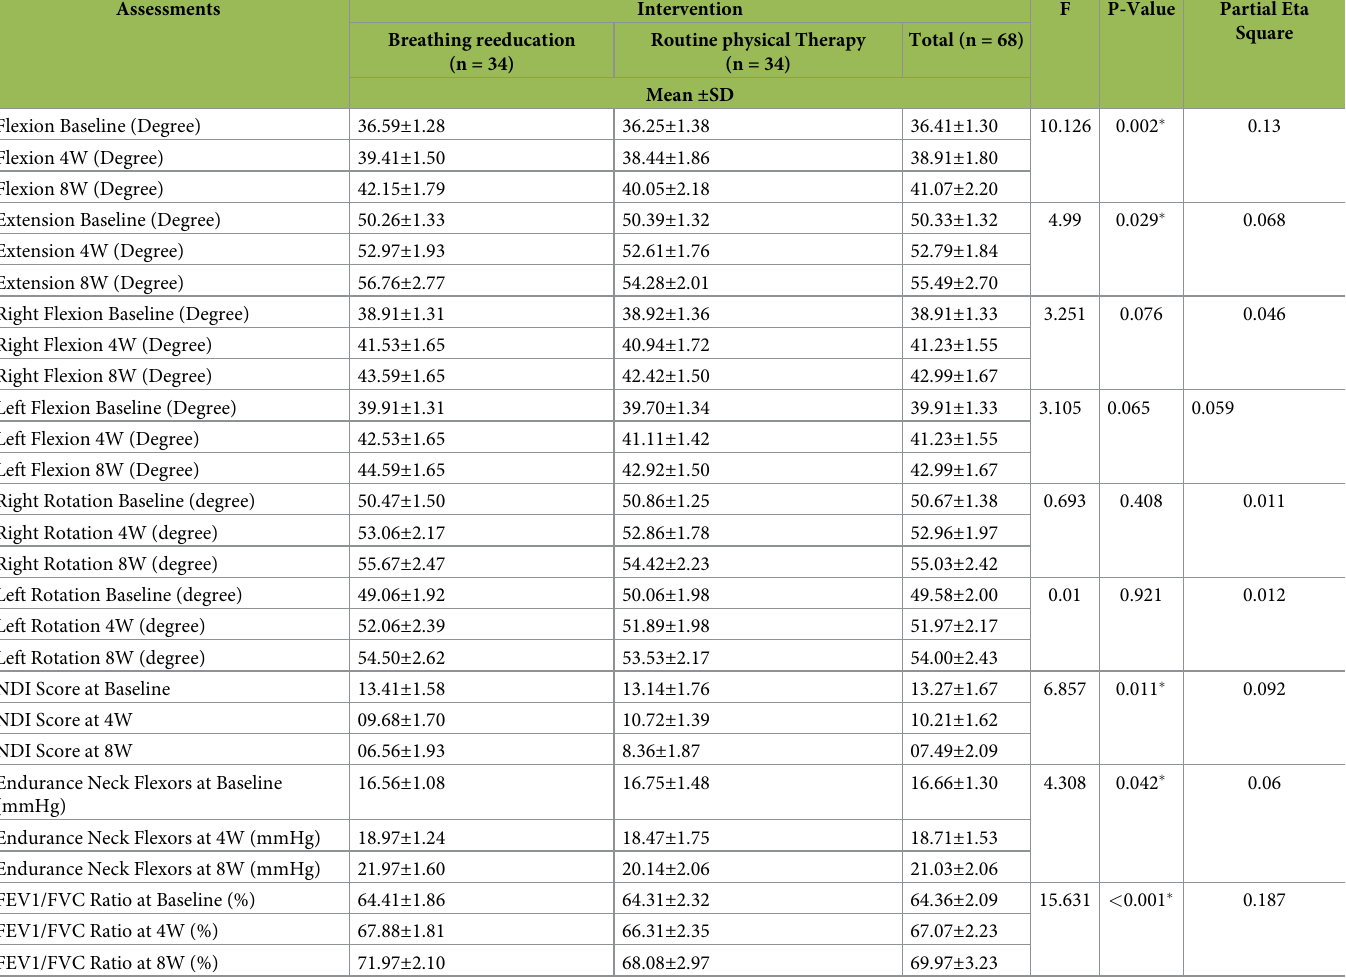
Table 2. Between groups comparison for CAROM, NDI, neck flexors endurance and FEV1/FVC ratio.